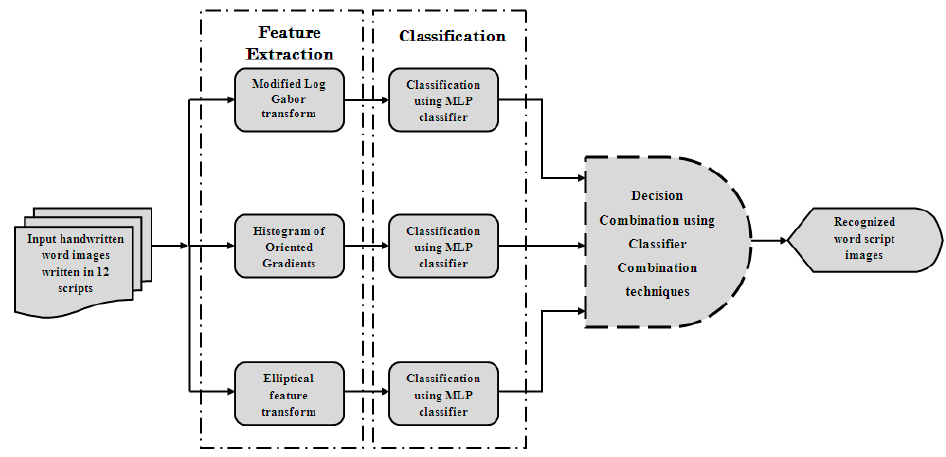
Figure 1. Schematic diagram of the proposed methodology.